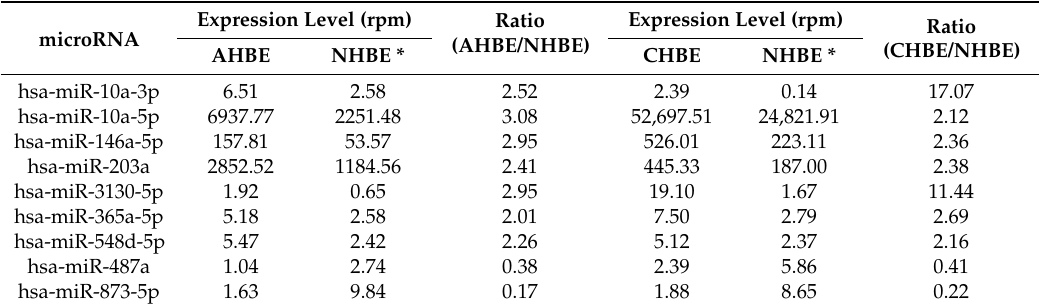
* The primary human bronchial epithelial cells (HBEs) used for next-generation sequencing (NGS) Table 1. Common microRNA changes identified from the results of next-generation sequencing (NGS). included HBE from an asthmatic patient (AHBE), HBE from a patient with chronic obstructive pulmonary disease (CHBE), and HBEs from normal subjects (NHBEs). Because of different timing of the study, different NHBEs were used for the NGS analyses that comparing the expression levels of microRNAs between AHBE and NHBE and between CHBE and NHBE. rpm, read per million.